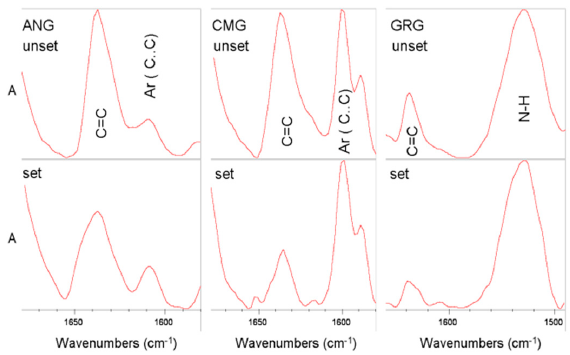
Figure 4. Expanded ATR-FTIR absorbance spectra used for the calculation of the degree of conversion (DC%) with the corresponding